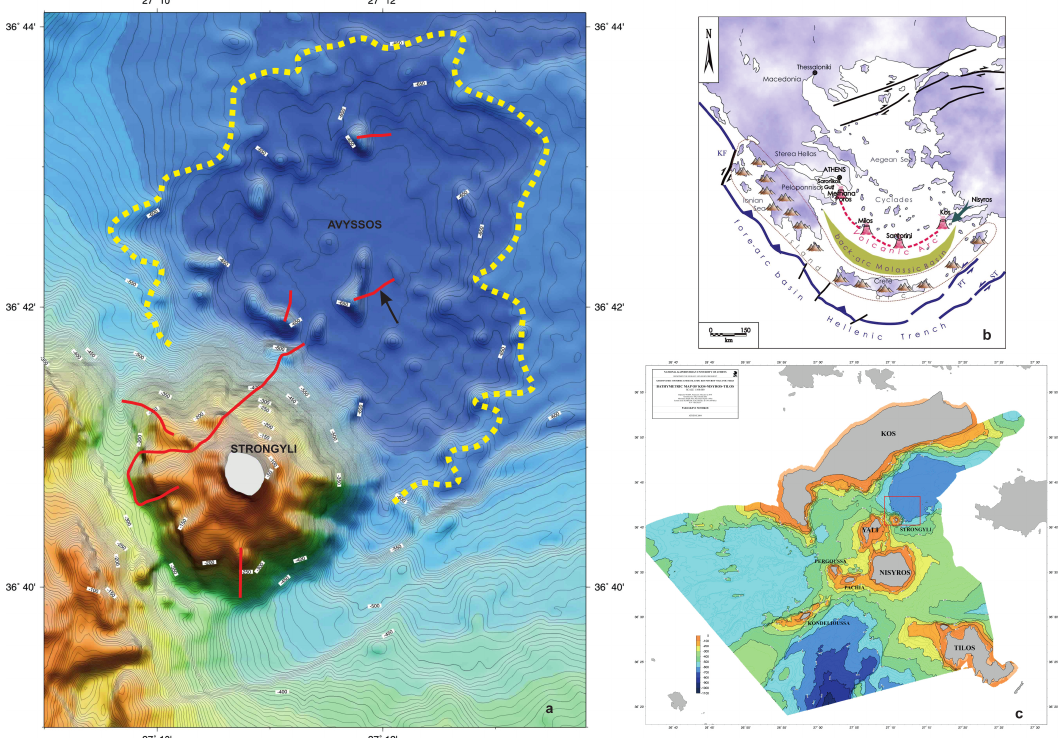
Figure 1. ( a ) A bathymetric map of Avyssos off the coast of Nisyros (adopted from [8]). The yellow dashed line roughly defines the borders of Avyssos caldera and the red lines the ROV transects. A black arrow indicates the location of the ROV during data sampling. ( b ) The geodynamic structure of the Hellenic Arc. ( c ) The extended Kos-Nisyros-Tilos volcanic field in the eastern Aegean Sea is shown in the bottom right